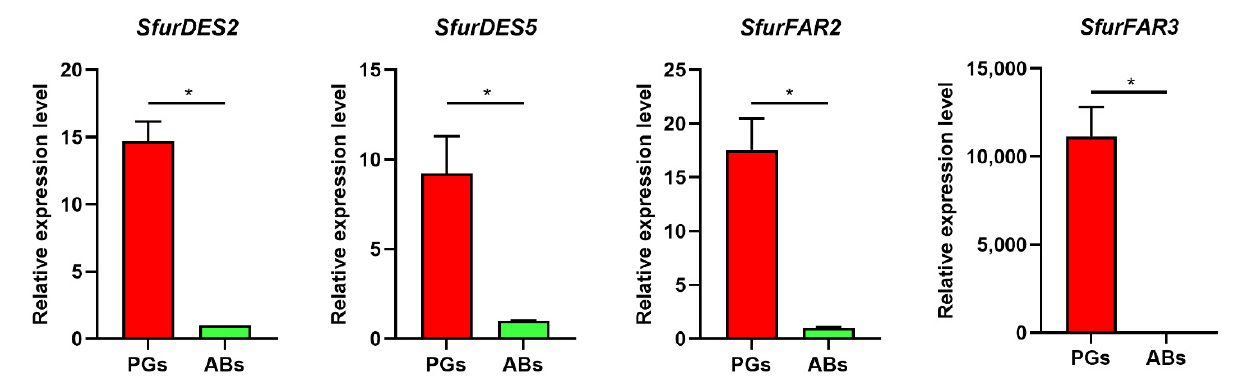
Figure 5. Relative expression levels of four sex pheromone biosynthesis genes. PGs: female pheromone glands, ABs: female abdomens without pheromone glands. The relative expression level (PGs VS ABs) is indicated as mean ± SE ( n = 3). The asterisk indicates a significant difference between PGs and ABs ( p < 0.05, Mann-Whitney U test).